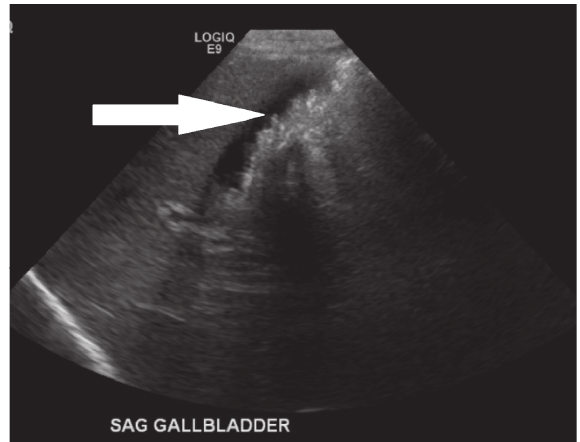
Figure 1: Biliary sludge in the dependent aspect of the gallbladder.